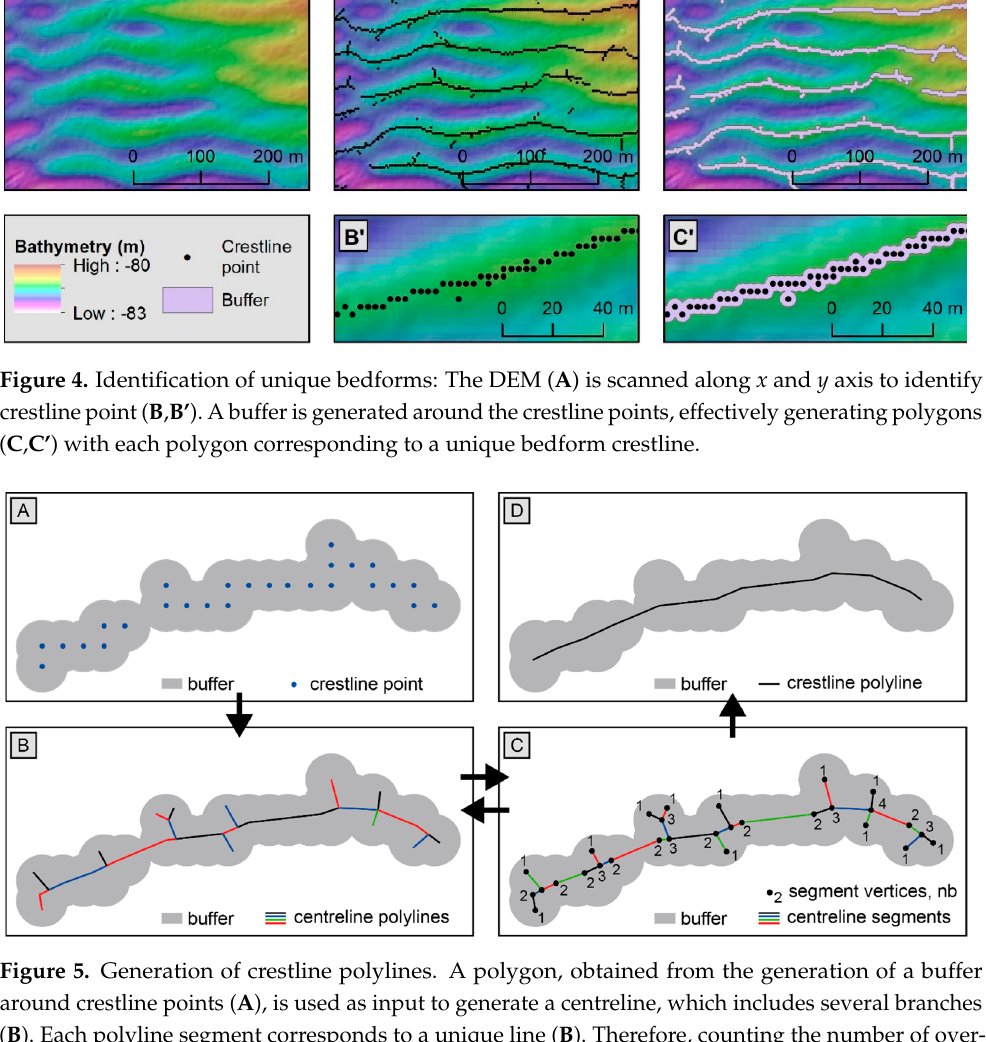
Figure 4. Identification of unique bedforms: DEM ( A ) is scanned along x and y axis to identify crest- line point ( B , B’ ). A buffer is generated around the crestline points, effectively generating polygons ( C , C’ ) with each polygon corresponding to a unique bedform crestline.